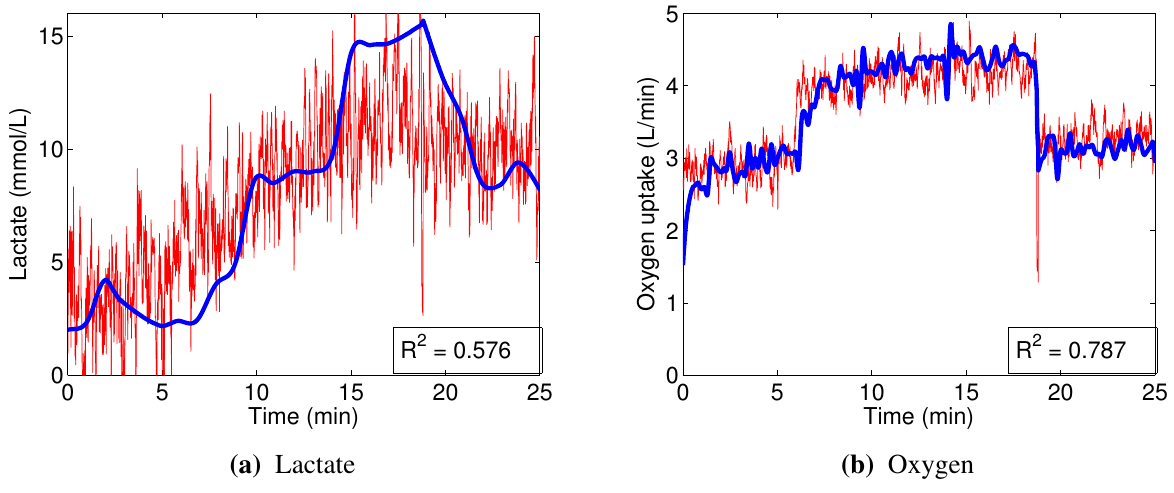
Figure 7. An example of predictions (red), compared to the interpolated ground truth (blue), made by the linear regression models, built using data from right vastus lateralis of Subject